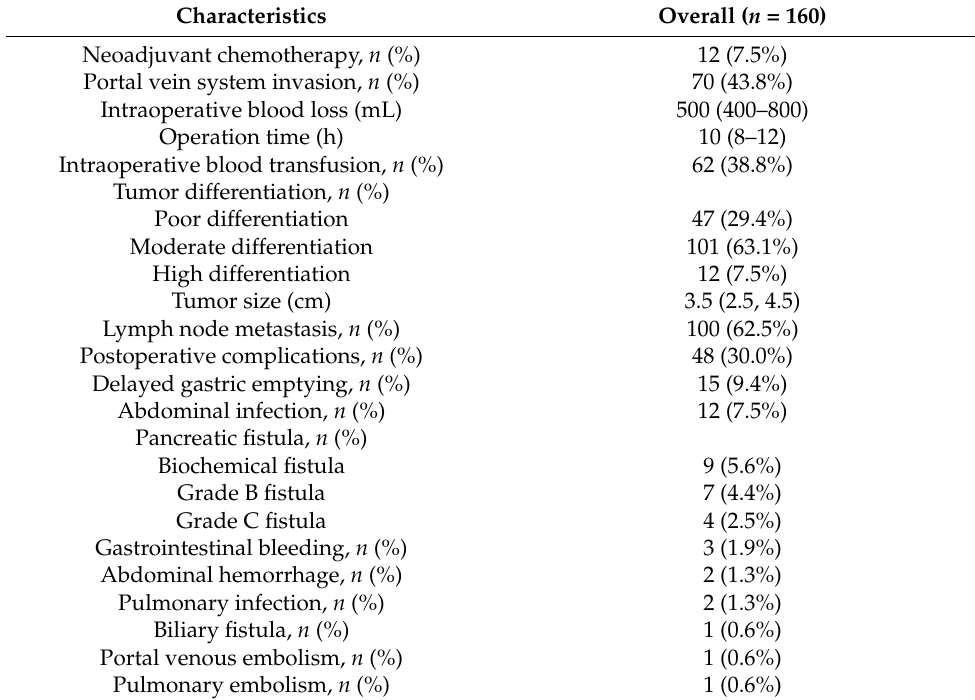
Table 2. Perioperative condition of the 160 pancreatic cancer